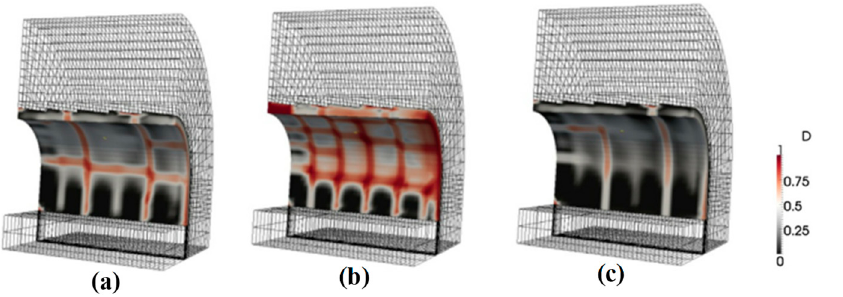
Figure 5. Damage field caused by different phenomena after 360 h (heat shrinkage and self-contrac- tion) [49]. ( a ) Creep is considered; ( b ) creep is ignored; and ( c ) only thermal shrinkage is considered.